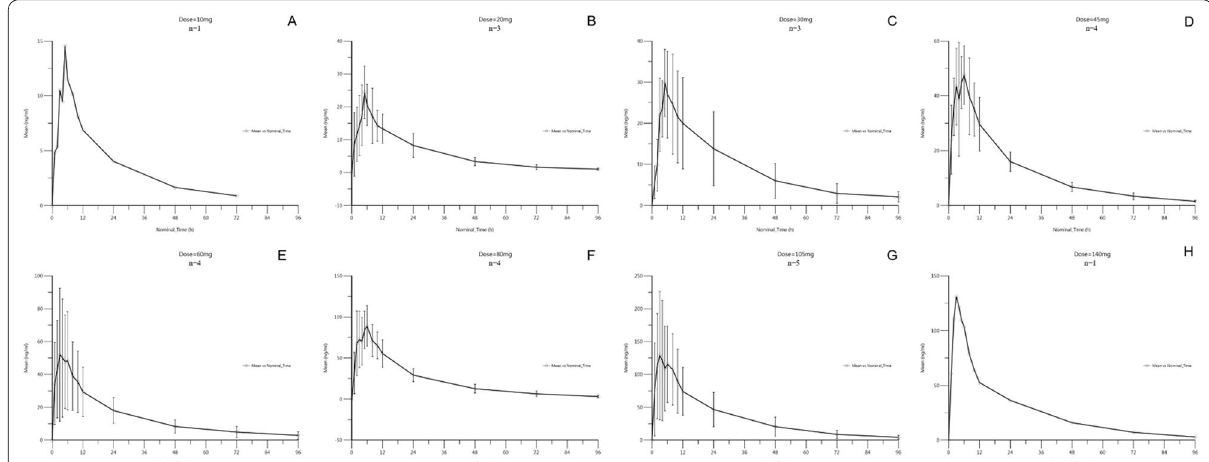
Fig. 3 The mean plasma concentration–time curves of NSCLC patients in different dose groups after single dosing of MET306. * The Mean plasma concentration–time profile of MET306 in human plasma following single oral administration of MET306 in different dose groups ( A : 10 mg, B : 20 mg, C : 30 mg, D : 45 mg, E : 60 mg, F : 80 mg, G : 105 mg, H : 140 mg) to NSCLC patients ( A : n n 5, H : n = =